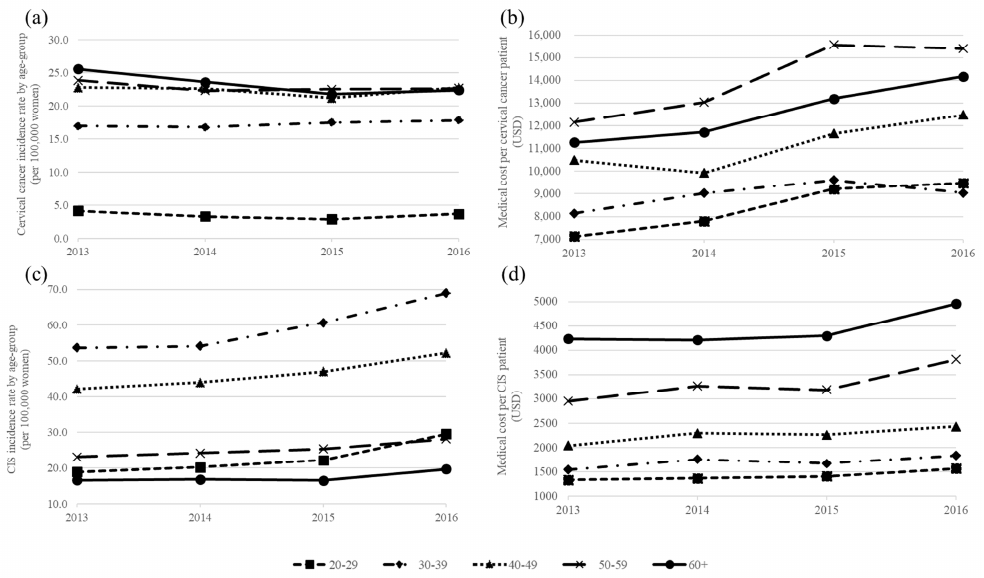
Figure 2. Age-specific incidence rate and mean medical costs of cervical cancer and CIS by year. ( A ) The age-specific incidence rate of cervical cancer was calculated per 100,000 people. ( B ) The mean medical cost of cervical cancer was adjusted by the 2016 medical care component CPI and converted to US dollars. ( C ) The age-specific incidence rate of CIS was calculated per 100,000 people. ( D ) The mean medical cost of CIS was adjusted by the 2016 medical care component of CPI and converted to US dollars.